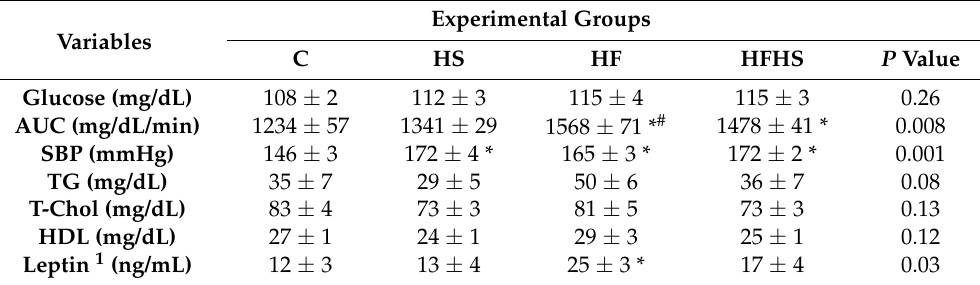
Table 2. Comorbidities and hormones associated with experimental diets.